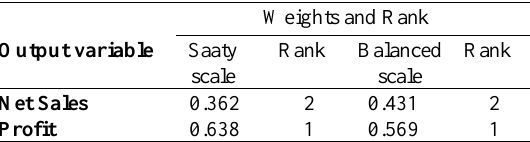
Table 6. Output weights obtained with two